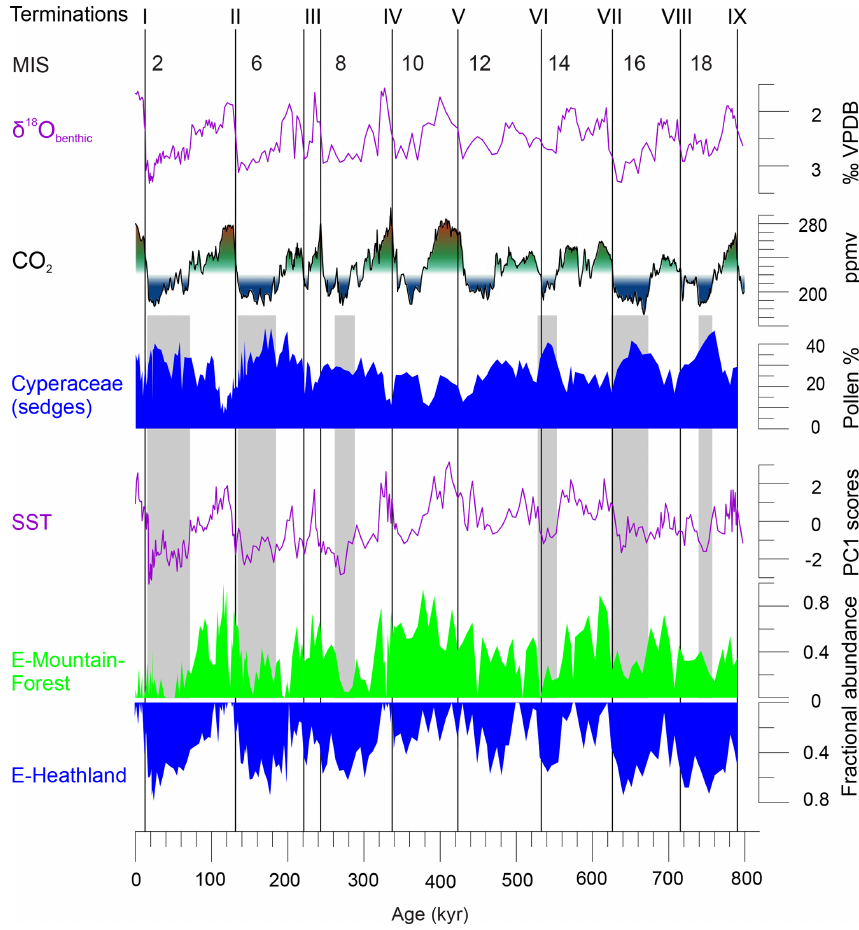
Figure 5. Comparing Cyperaceae pollen percentages and fractional abundances of the glacial pollen assemblages E-Mountain-Forest and E-Heathland with atmospheric CO 2 (Bereiter et al., 2015; PAGES, 2016) and sea surface temperatures of the southeastern Indian Ocean (SST PC1 scores of MD96-2048) (Caley et al., 2018d). On top are denoted terminations I through to IX of the past nine glaciations, even-numbered marine isotope stages (MISs), and stable oxygen isotopes of benthic foraminifera ( δ 18 O benthic ) of MD96-2048 (Caley et al., 2018b). CO 2 levels of 220 and 270ppmv are indicated with blue–green–red shading. Grey shading highlights periods with minimum atmospheric CO 2 , minimum values of E-Mountain-Forest and maximum values of E-Heathland and Cyperaceae pollen. VPDB: Vienna Pee Dee